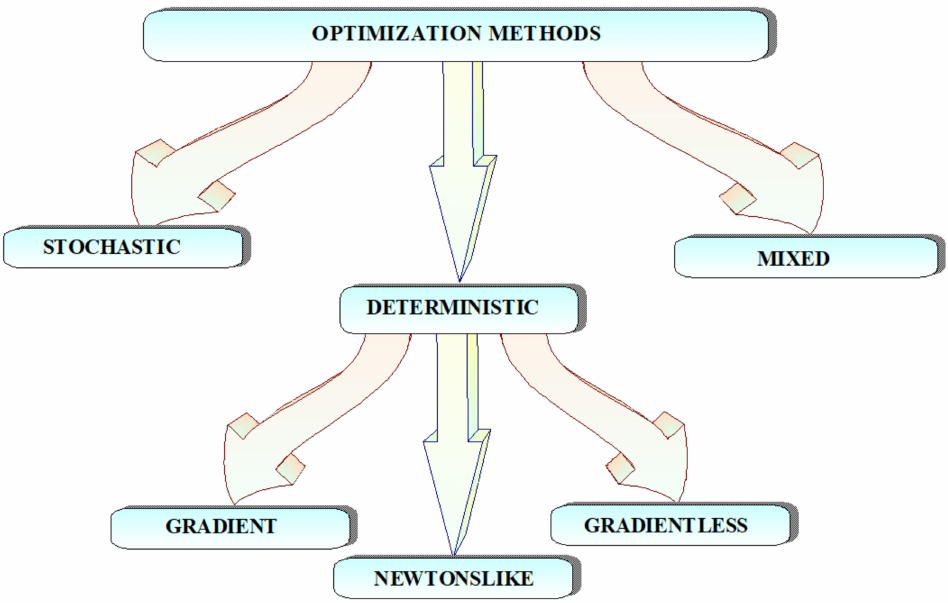
Figure 5. Optimization methods for parameter identification.